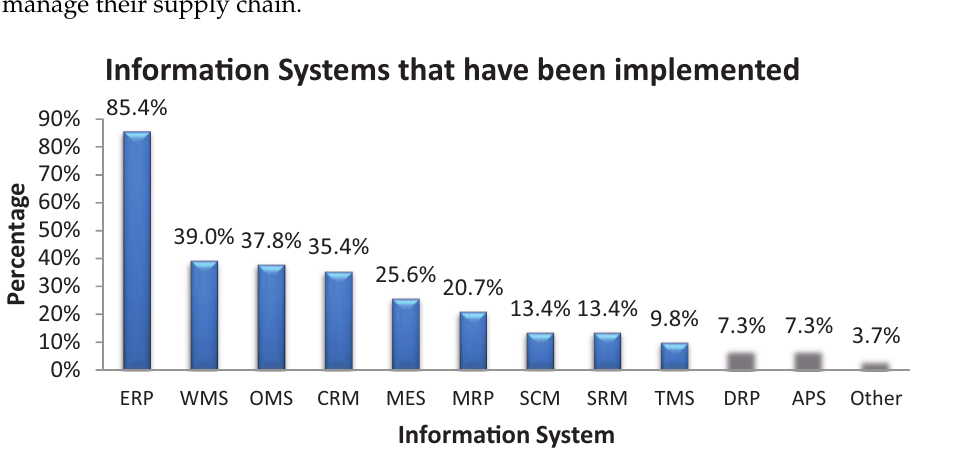
Figure 2. Information systems that have been